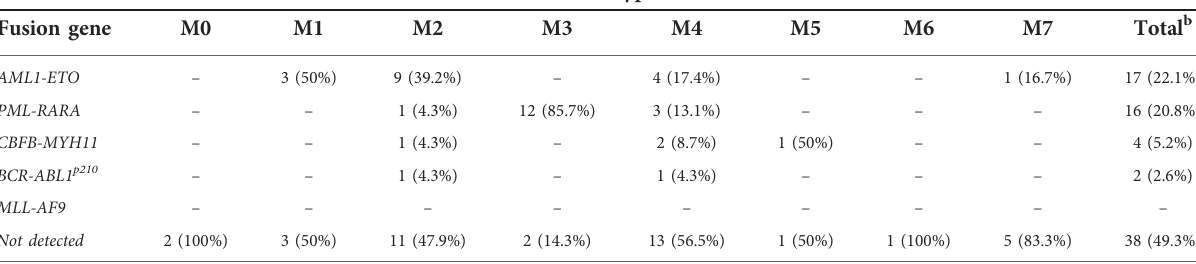
TABLE 2 Fusion gene frequencies and FAB subtypes of pediatric patients with AML.